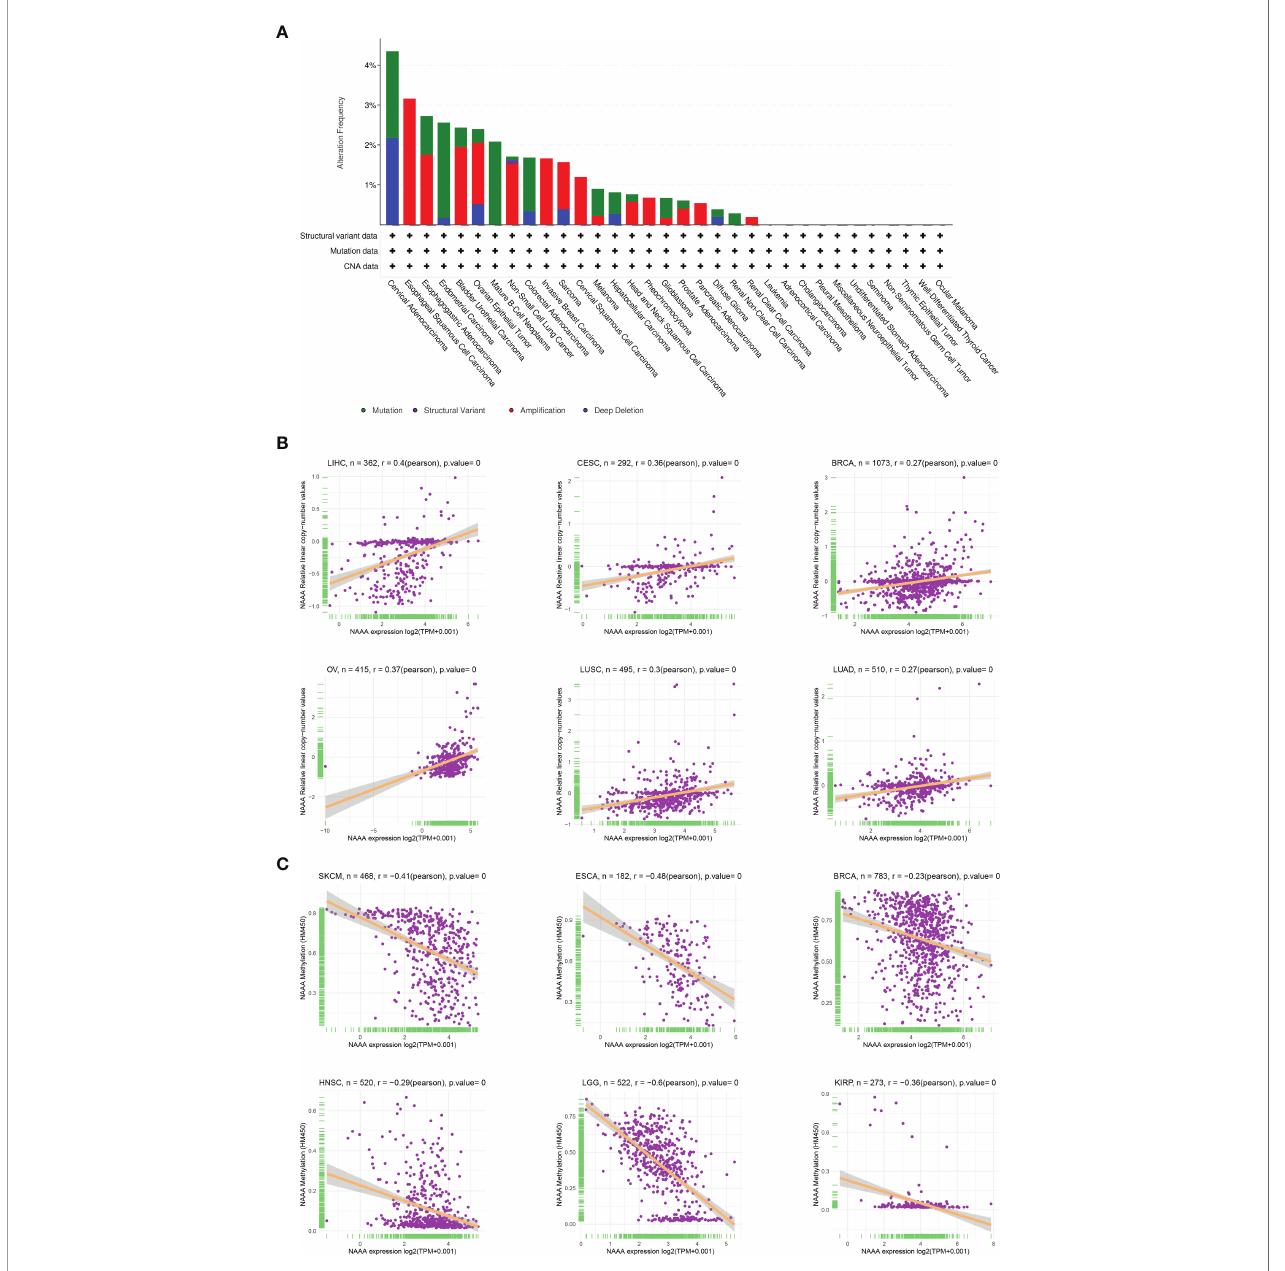
FIGURE 7 | Relationship of NAAA expression with gene alterations. (A) The genetic alteration type and frequency of NAAA in various cancers. (B) Correlation between NAAA expression and gene promoter methylation in liver hepatocellular carcinoma (LIHC), cervical squamous cell carcinoma (CESC), breast invasive carcinoma (BRCA), ovarian cancer (OV), lung squamous cell carcinoma (LUSC), lung adenocarcinoma (LUAD). (C) Correlation between NAAA expression and copy number variation in skin cutaneous melanoma (SKCM), esophageal carcinoma (ESCA), breast invasive carcinoma (BRCA), head and neck squamous cell carcinoma (HNSC), brain lower grade glioma (LGG), kidney renal papillary cell carcinoma